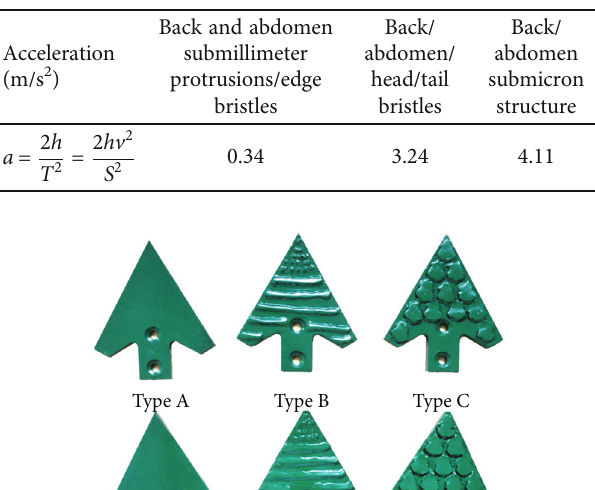
Table 2: The acceleration of soil restoration to its original state at di ff erent scales.